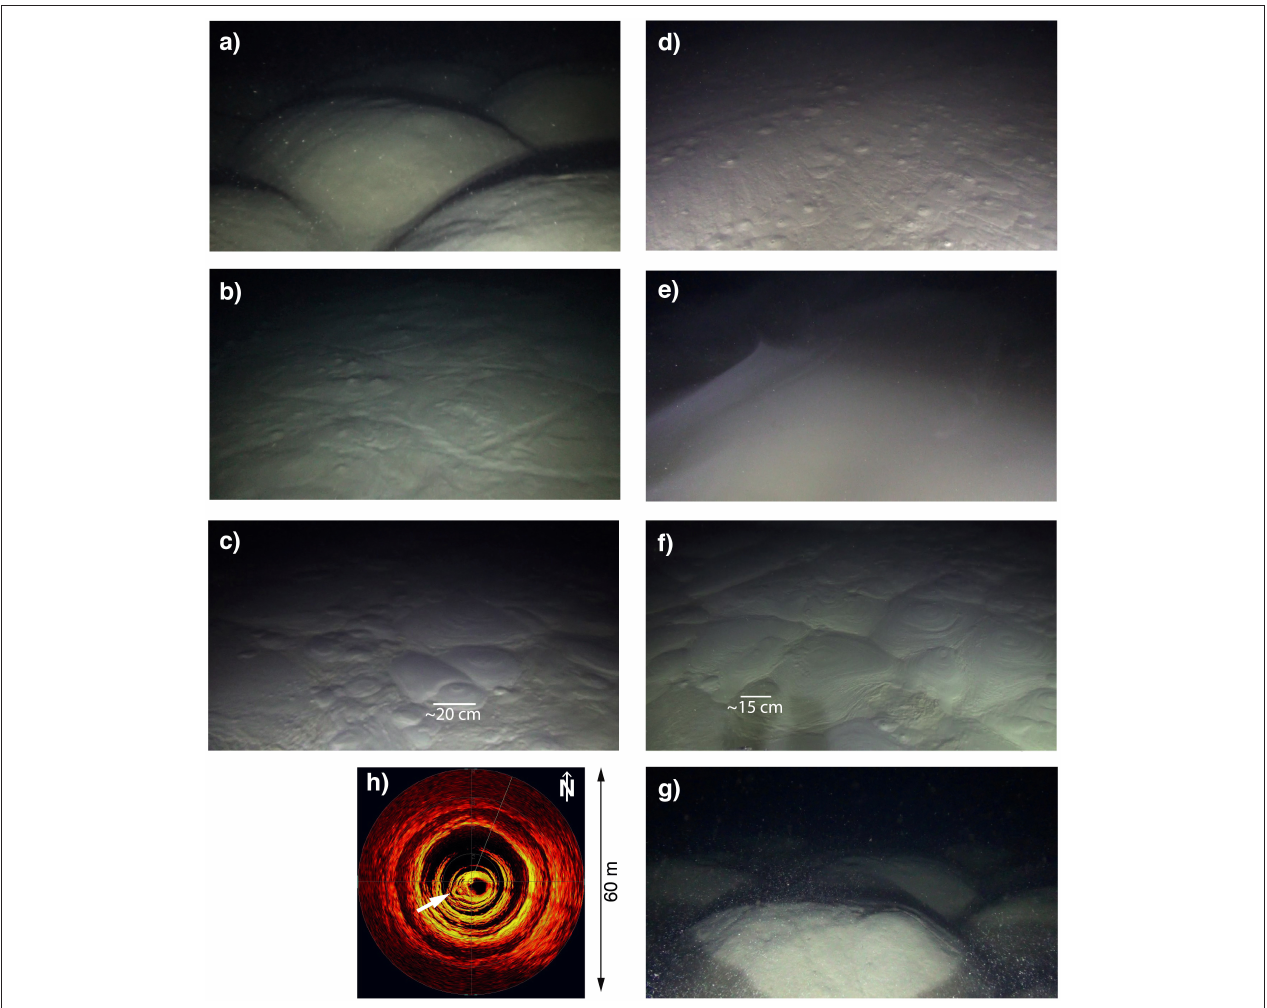
FIGURE 4 | Pictures and 360 ◦ sonar scan recorded during the ROV survey illustrating the lake-floor morphology outside and inside of the pockmarks. (a) Sediment pillow structures outside of the CB pockmark, representing the normal lake floor; (b) appearance of mini mud volcanoes at the surface of the sediment suspension as well as fish tracks between the outer and inner rim of CB; (c) mini mud volcanoes in the center of CB; (d) same as (b) but for TR3; (e) center of TR3 characterized by a high turbidity and a not detectable sediment surface; (f) same as (c) but for TR2; (g) pillows inside of TR1; and (h) 360 ◦ sonar scan recorded when the ROV was located in the funnel of LL highlighting the anomaly in the pockmark wall (white arrow) where groundwater presently possibly enters the